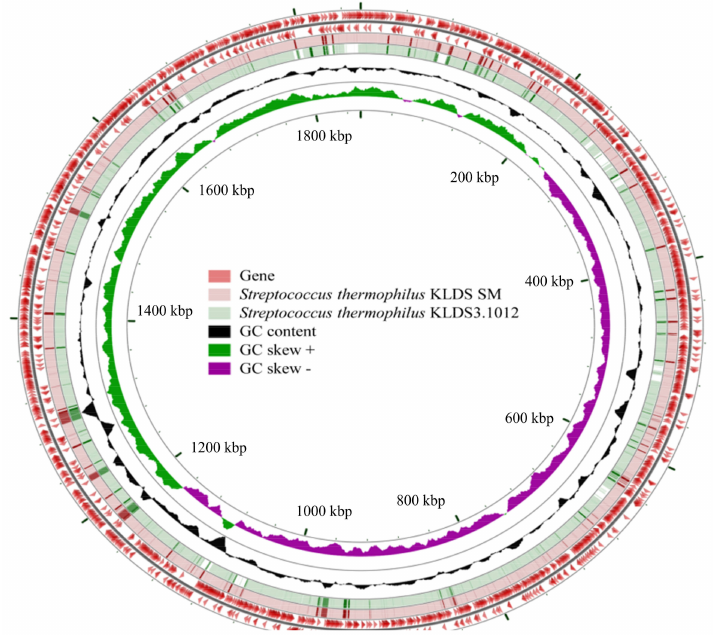
Figure 2. Circular genome map of S. thermophilus KLDS SM and KLDS3.1012. From outside to inside: Circles 1 and 2 showed the locations of genes, including protein coding genes CDS, rRNA, tRNA and other genes on positive and negative chain; Circles 3–4 showed the comparisons of S. thermophilus KLDS SM and S. thermophilus KLDS3.1012 through blastn; Circles 5 and 6 showed GC content and GC skew.